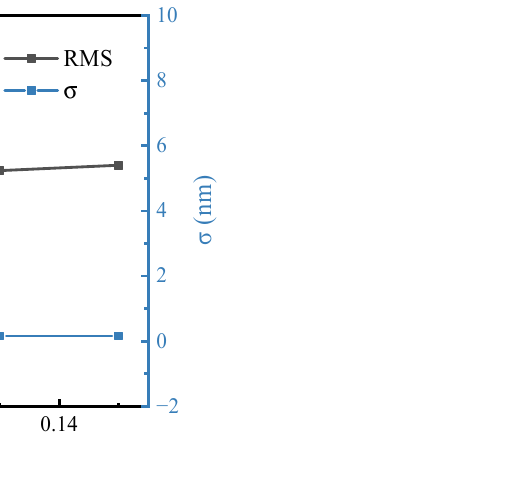
Figure 11. RMS and σ as a function of Si/H ratio, the Si/H ratio is 0.08%, 0.10%, 0.12%, 0.13%, and 0.15%, respectively.